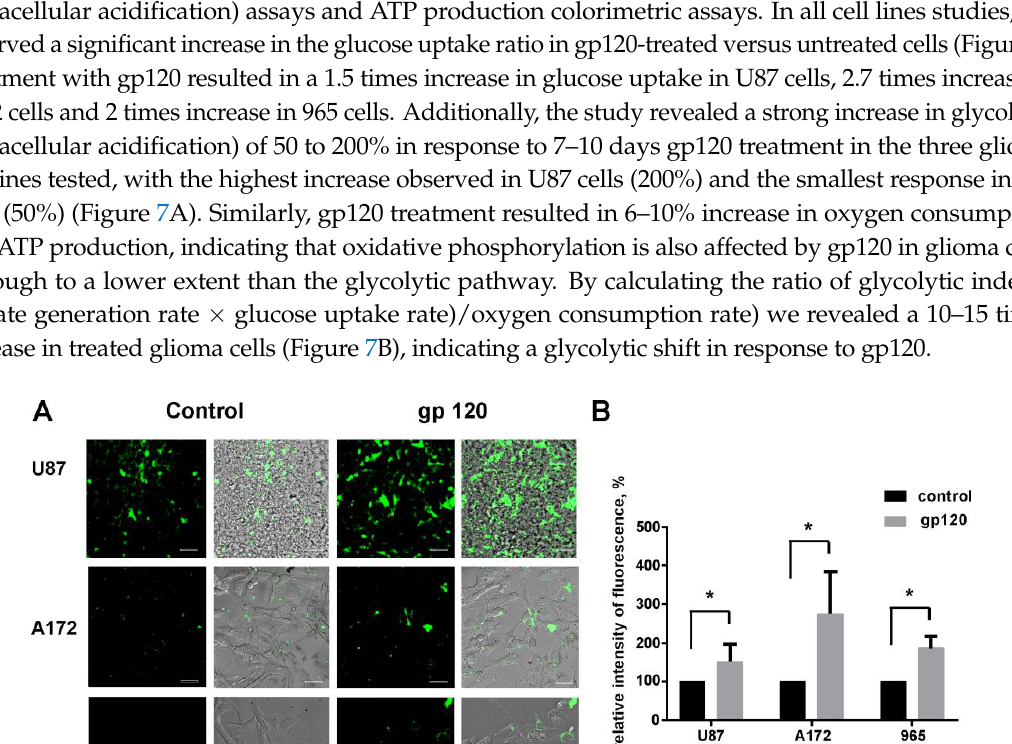
Figure 6. Gp120 increases glucose uptake in glioma cells. Glucose uptake assays were performed for untreated and gp120 treated for 7–10 days U87, A172 and 965 glioma cells. Confocal images showing